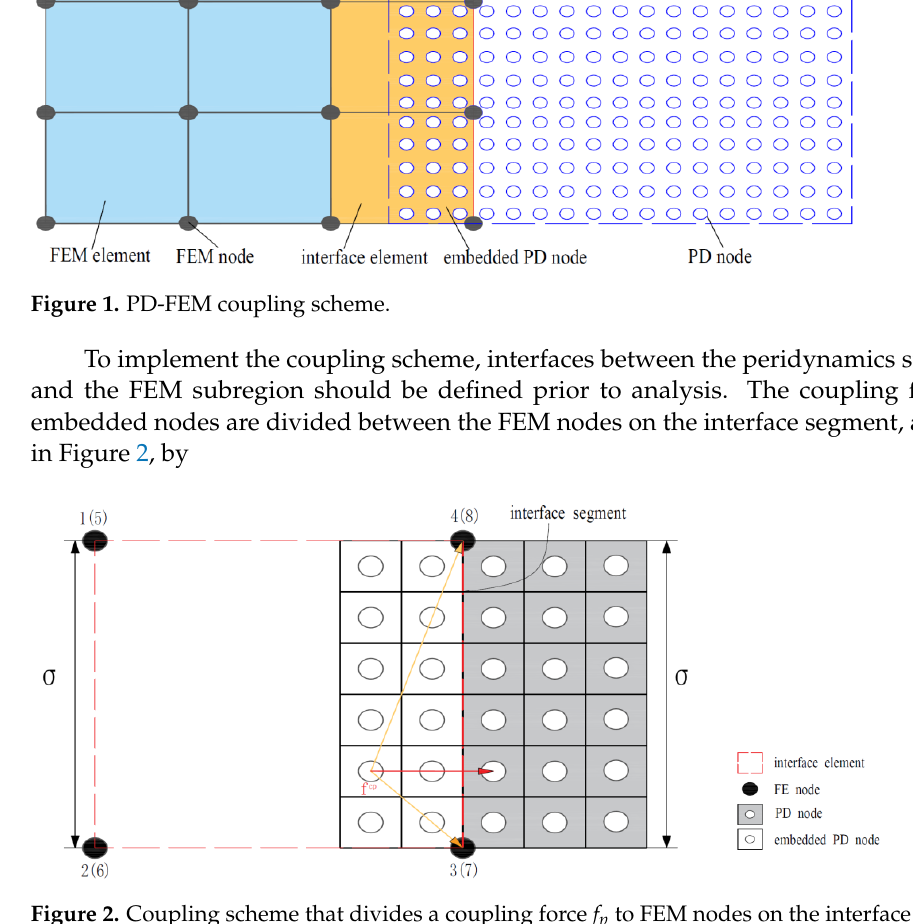
p to FEM nodes on the interface